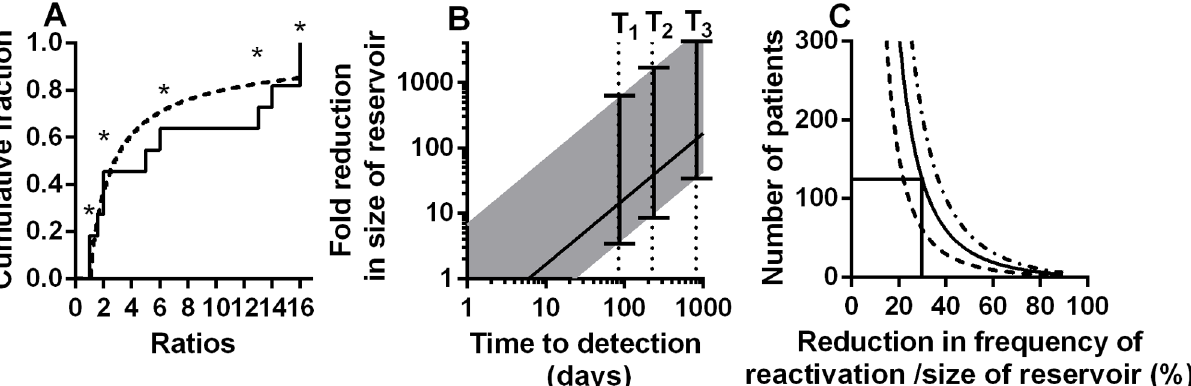
Fig 5. Modelling of kinetics of time-to-detection: A: Using the ratio of the number of copies of reactivation founder viruses to estimate rate of initiation of viral growth. The cumulative proportion of founders with different ratios (to the size of next largest founder) is shown. Solid line is ratios from the experimental data, dashed line is the theoretical distribution with the best fit frequency of rebound of once every 3.6 (CI 1.98 – 6.62) days. Ratios marked with an asterisk are where we could only estimate a minimum ratio (ie: there was no detected next founder virus). (B) Estimating the reduction in frequency of recrudescence (and reservoir size) from observed delay to detection of virus. For a ‘ normal ’ reservoir size, we find an average frequency of reactivation of once every 6 days (which also equates to an average delay to reactivation of 6 days). For patients with longer time-to-detection we can estimate the relative size of the reservoir compared to our cohort populations. Solid line shows the fold reduction in reservoir size that would be estimated simply comparing the observed time to detection with the estimated average of 6 days. Since reactivation does not always occur at the average time, the range expected for 95% of subjects is shown (shaded area). T 1 and T 2 are the delays for two patients that underwent allogeneic stem cell transplantation (reference [30]). T 3 is the delay observed in the ‘ Mississippi baby ’ (reference [29]). (C) Difficulties using treatment interruption studies to measure changes in the reservoir. The number of patients required (y-axis) to have a 50% (dashed line), an 80% (solid line) or a 95% (dot-dash line) power to detect a given reduction in reservoir (x-axis) is shown, based on Log-rank test. This assumes a 100-day follow up after ART-interruption.